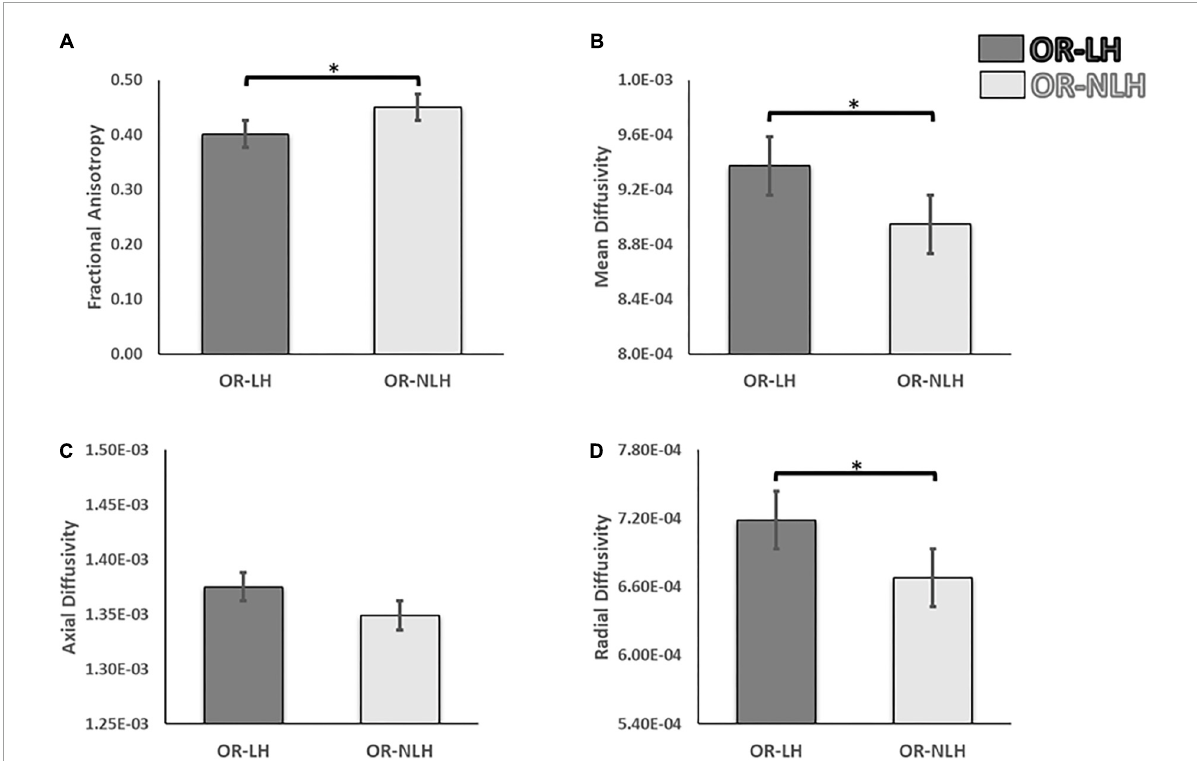
FIGURE3 Differences in white matter integrity of the OR of the lesional and non-lesional hemispheres in children with USCP. (A) Mean fractional anisotropy, (B) mean diffusivity (C) mean axial diffusivity and (D) mean radial diffusivity. OR-LH, optic radiation of the lesional hemisphere; OR-NLH, optic radiations of the non-lesional hemisphere. Error bars represent standard errors of the mean. ∗ p < 0.05.